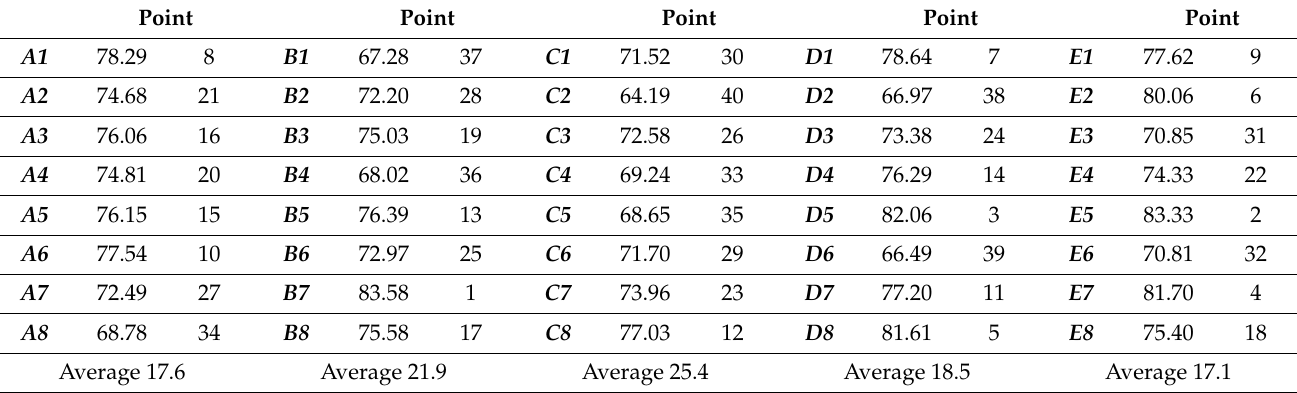
Table 8. Improvement ratio indices on cylinders manufactured with different technologies for R q .